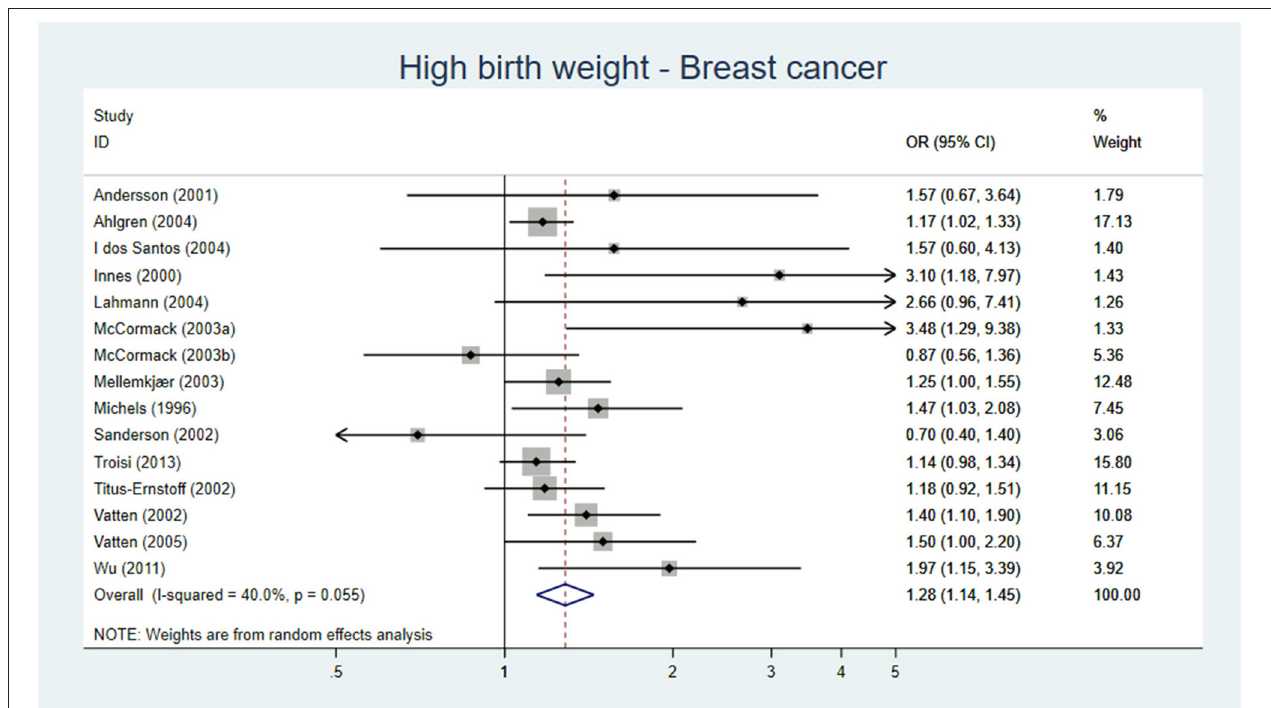
FIGURE 2 | Forest plot describing the association between high birth weight and breast